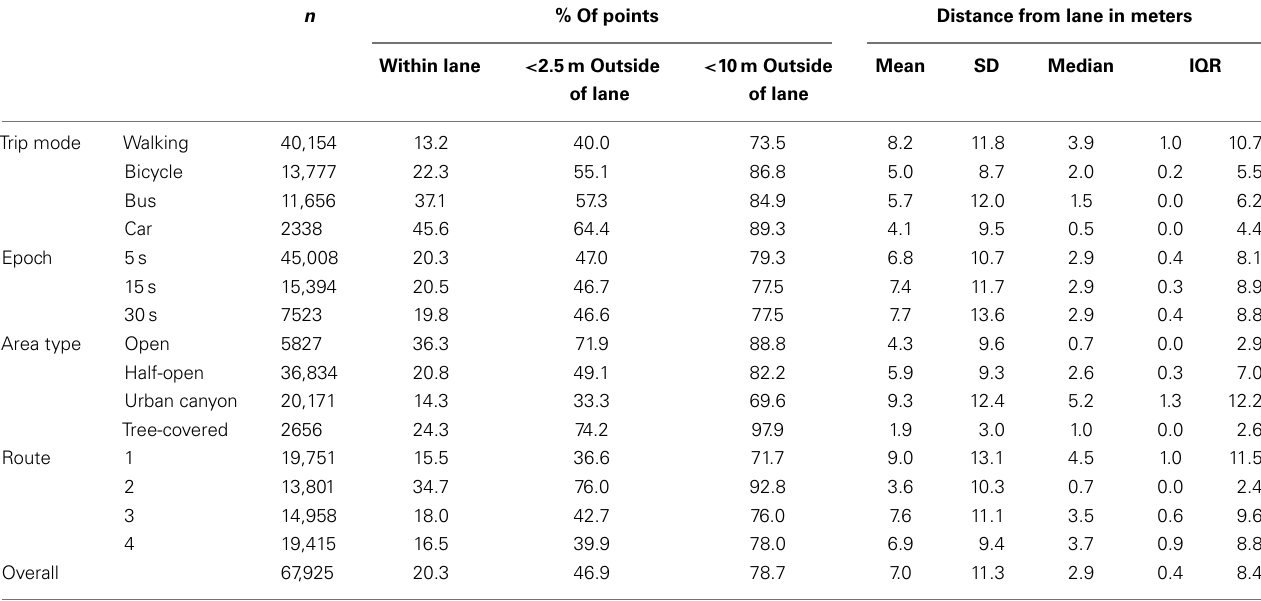
Table 1 | Dynamic spatial accuracy in percent of points and mean and median errors in meters, overall as well as divided by trip mode, epoch, area type, and route